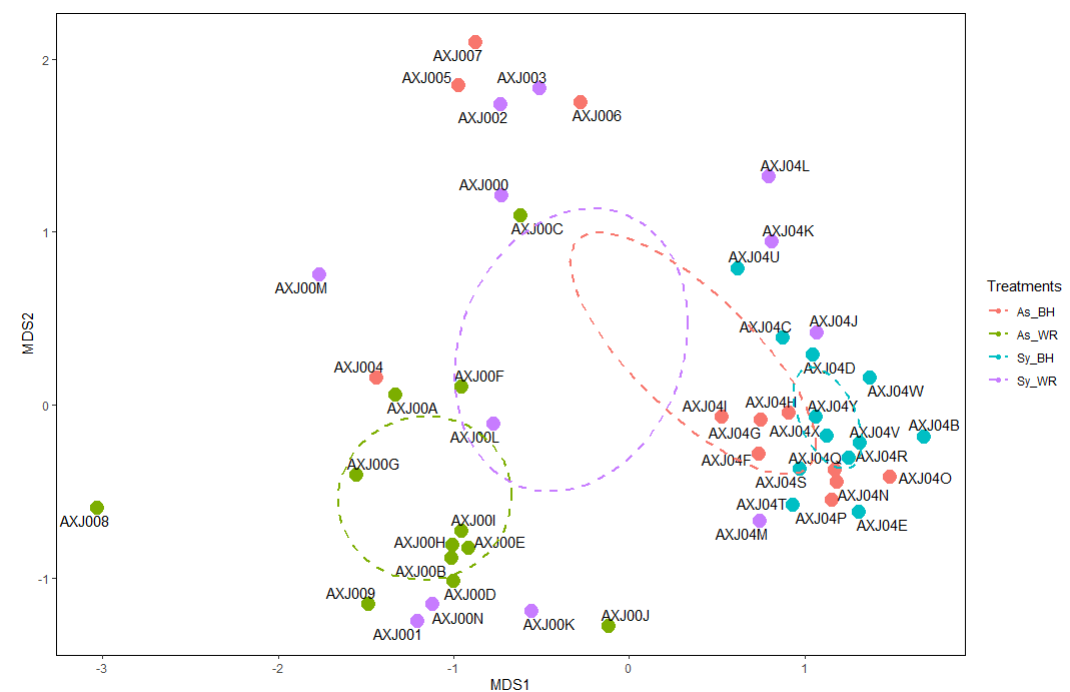
Figure 4. Ordination of wood fungal communities at the ASV level using a non-metric multidimensional scaling (NMDS) analysis on a Bray–Curtis dissimilarity matrix. Ellipsoids represent 95% confidence regions for each group (Site) mean.